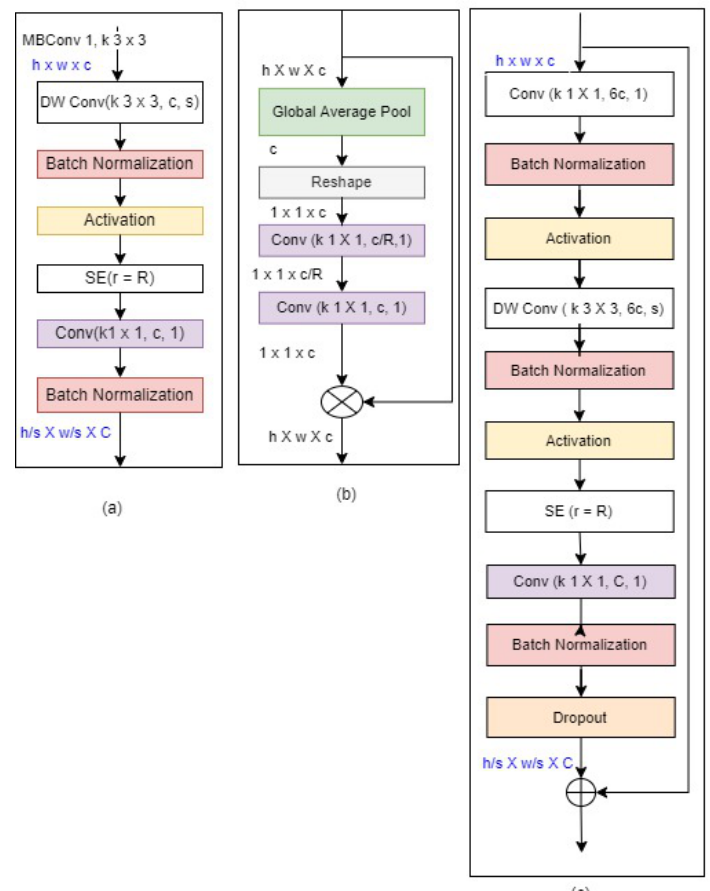
Figure 2. EfficientNet Blocks: ( a – c ) are the 3 basic building blocks. h, w, and c are input with respect to height, width, and channel for all the MBConv blocks. The Output channel for the two blocks is denoted by